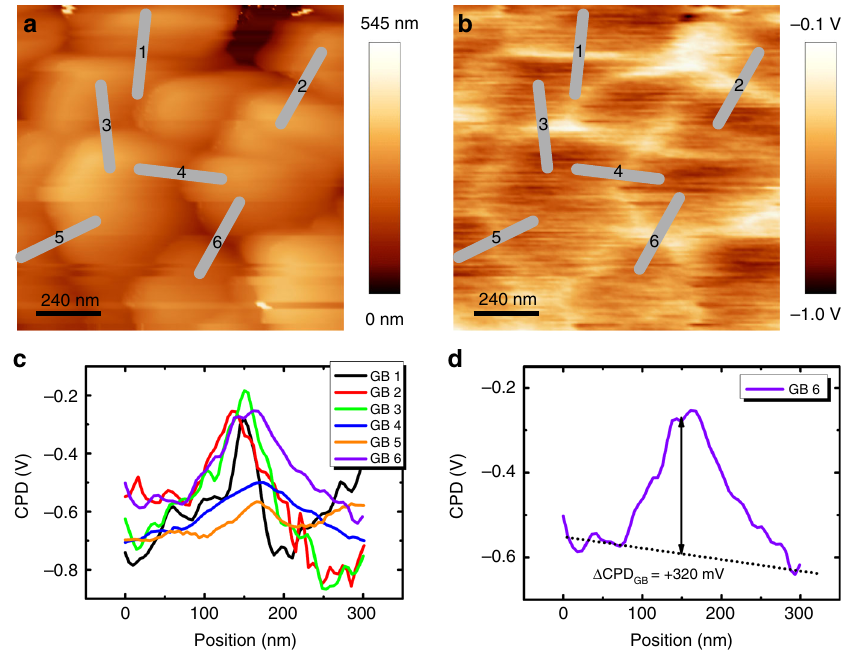
Fig. 2 KPFM measurements on KF-PDT CIGSe. a Topography and b simultaneously acquired contact potential difference (CPD) map in dark conditions. The GBs analyzed in this study are marked by grey lines that cross the GB perpendicular. c Line pro fi les extracted from the CPD image. d Individual line pro fi le of GB 6 to illustrate that the potential variation ( Δ CPD GB ) of each GB corresponds to the difference between CPD GB at the GB and the average < CPD > GS obtained on the grain surfaces of the adjacent